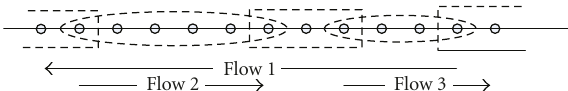
Table 2: Signal to Noise Ratio with di ff erent path loss exponent